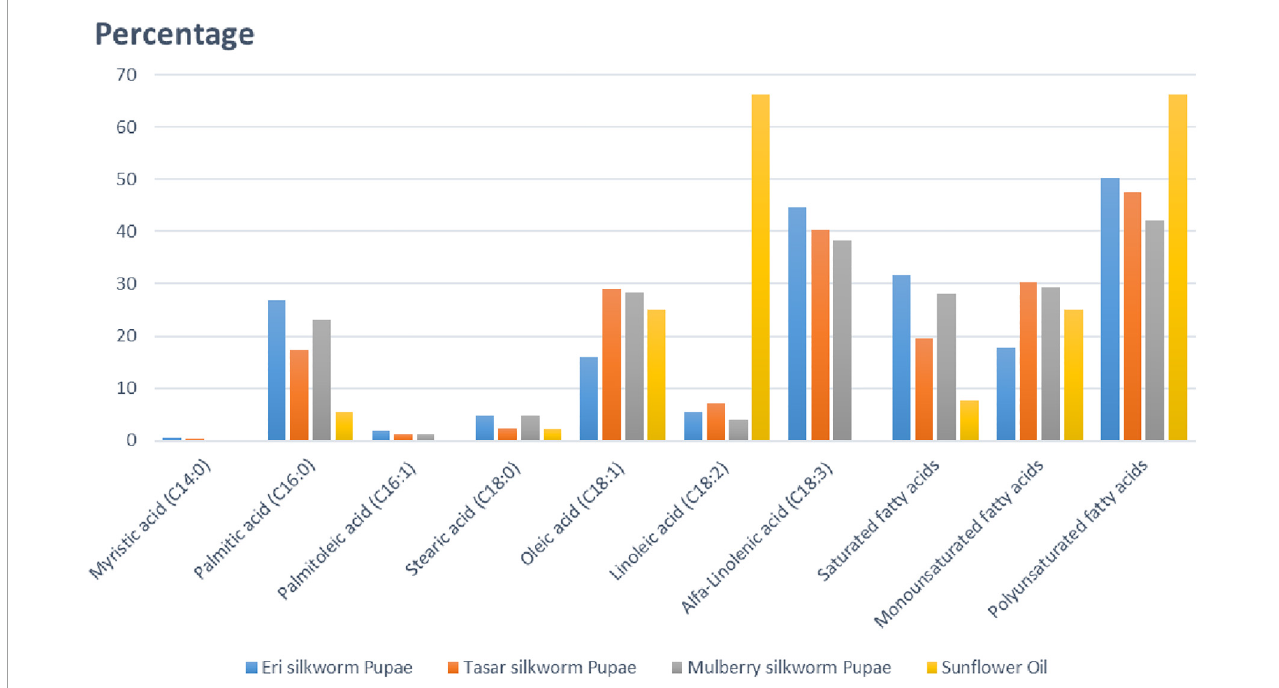
FIGURE5 Representing quantity of fatty acids (in percentage) present in pupae of silkworms (mulberry, eri, tasar) in comparison with sunflower oil. Palmitic acid is more in eri silkworm pupae, Oleic acid is more in tasar silkworm, Saturated fatty acids are more in eri silkworms, polyunsaturated fatty acid is more in eri silkworm pupae in comparison with other silkworm pupae. Out of four different species of silkworm pupae, Eri silkworm pupae has the highest oil content, at 26.2%. All the different silkworm pupae oils contain high levels of unsaturated fatty acids (both monosaturated and polysaturated), with 77.71% in Antheraea pernyi . Silkworm pupae are not only rich in oils but also contain high levels of unsaturated fatty acids, especially polyunsaturated fatty